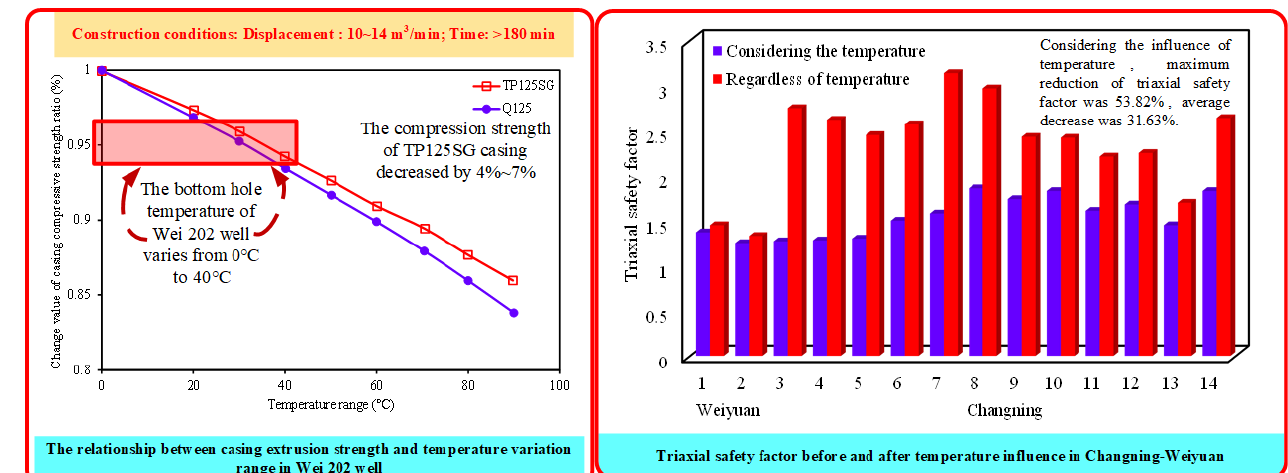
Figure 8. Relationship between temperature and casing strength.